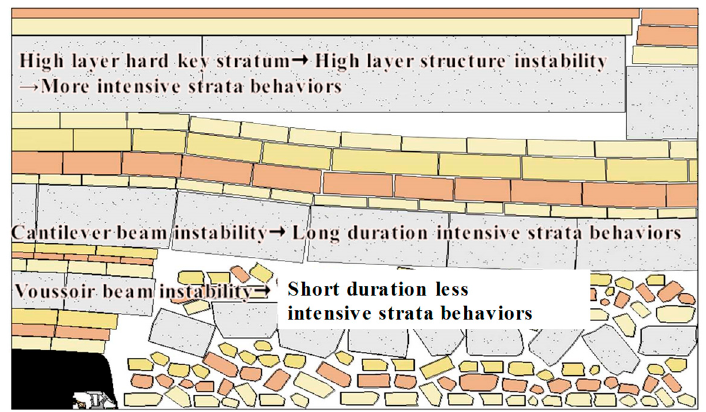
Figure 10. Strata structure and strata behavior characteristics.